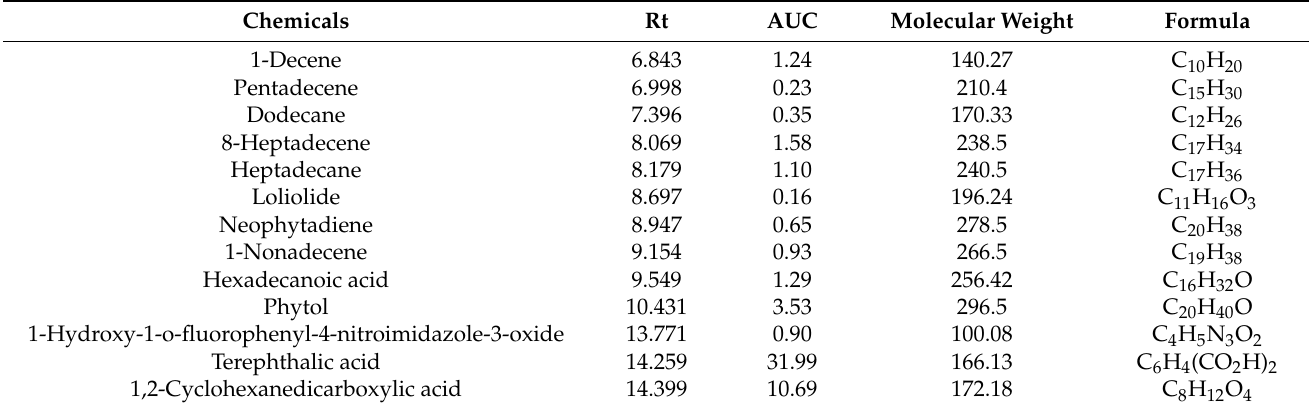
Table 2. Identified chemicals in Bulung Anggur